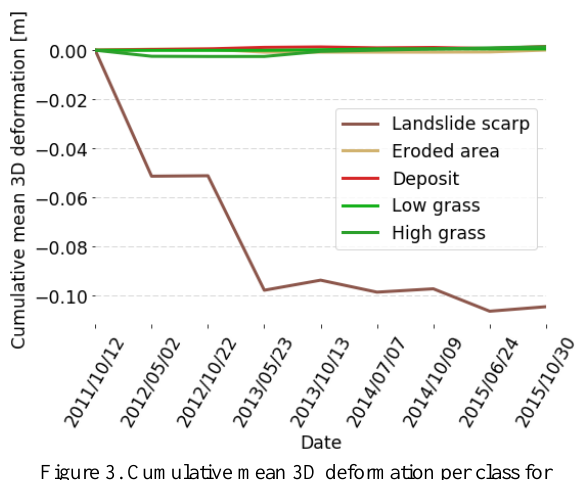
Figure 3. Cumulative mean 3D deformation per class for landslide L1 ( reg = 0.1 m).